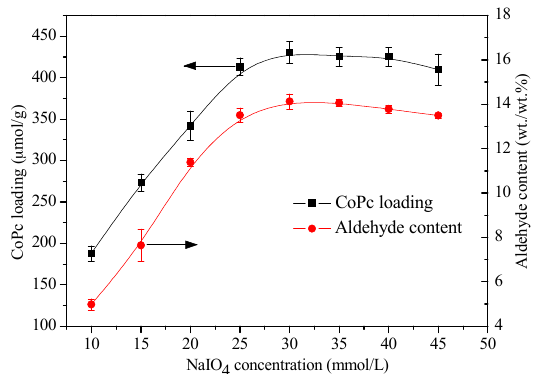
Figure 5. Effect of NaIO 4 concentration on CoPc loading of CoPc@BC (filled square) and aldehyde content of BC (filled circle), T = 30 °C, reaction time = 8 h.